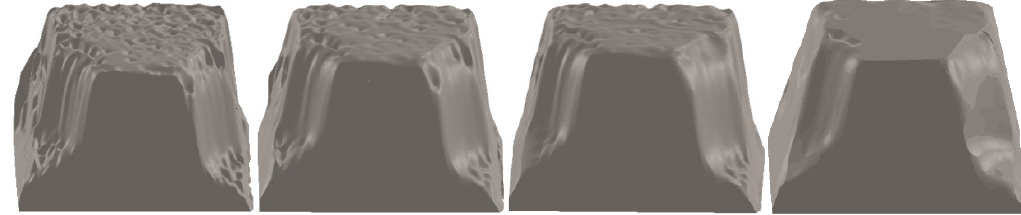
Figure 21. 3D entities using different evaluation windows reconstructed by FSML focus evaluation operator.